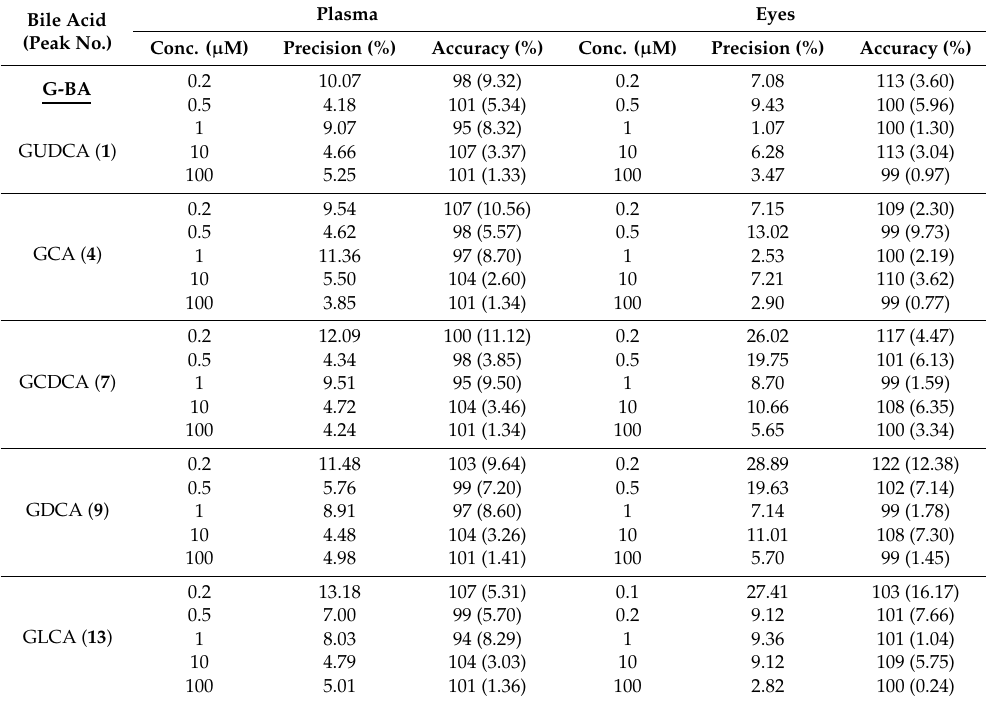
Table 1. HPLC method validation results of glycine-conjugated bile acids (G-BA) in mice plasma and eyes ( n = 3) 1 .